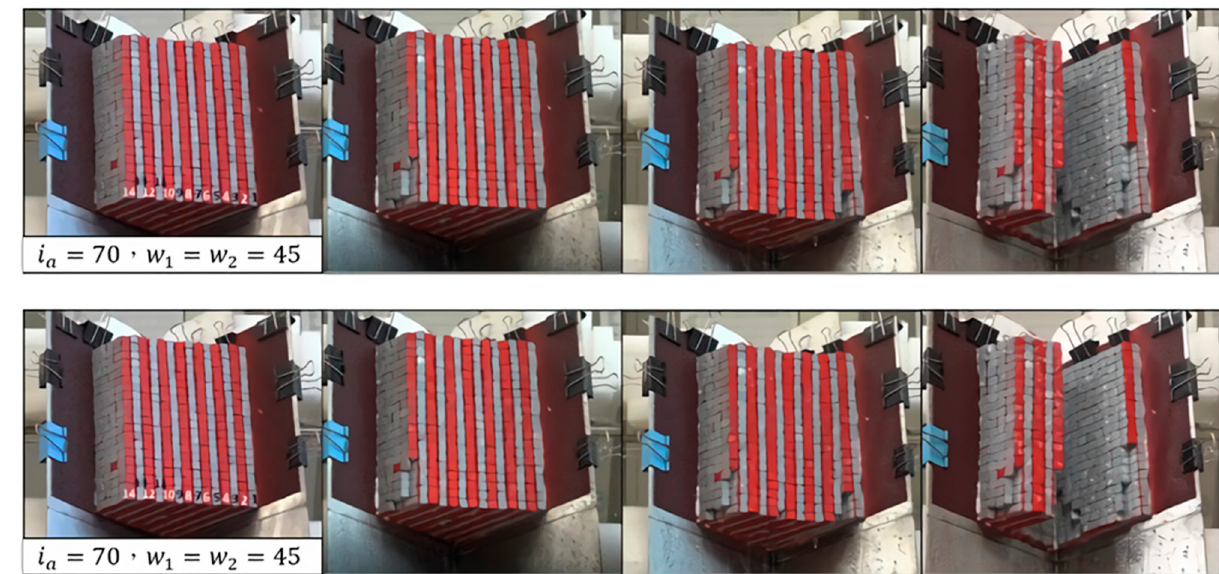
Figure 15. Comparison of tests with ω = 45° and different i a.